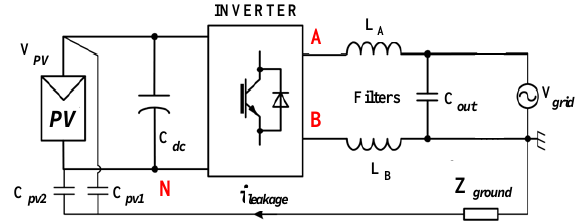
Figure 2. Equivalent circuit of a PV transformerless inverter.